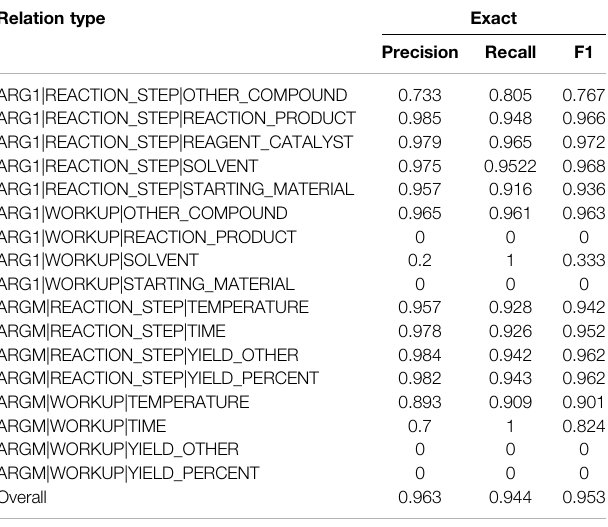
TABLE5| Performancesoneachrelation typeandtheoverallperformanceonthe development set are reported. The fi ne-tuning method was used in the